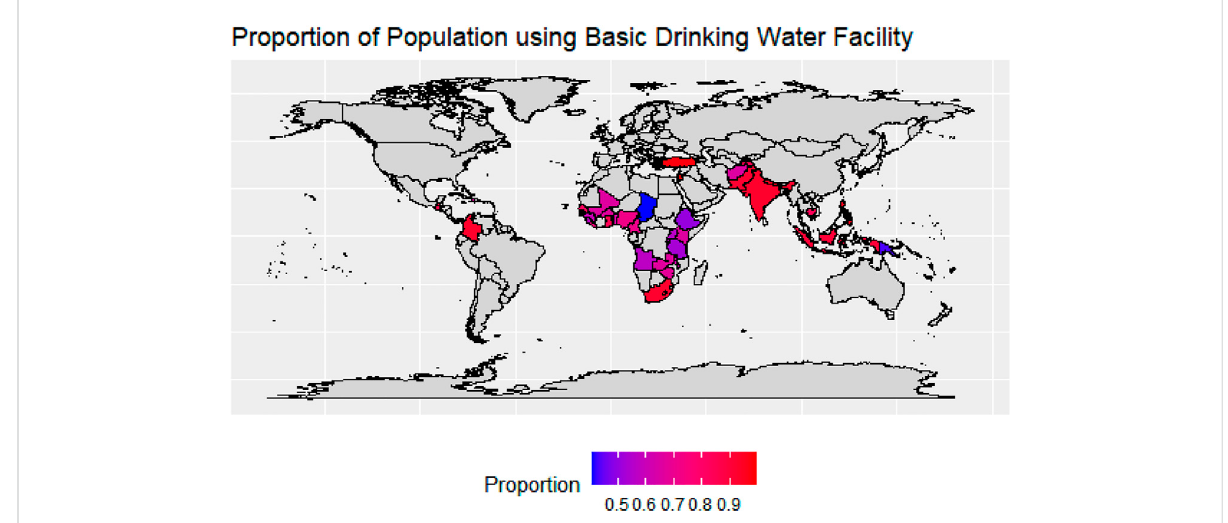
FIGURE 2 Proportion of population using basic drinking water facility in the study countries. Note: Proportion estimated as the share of sampled households using basic drinking water facility to the total sampled households by countries. Source: Authors estimation based on the DHS